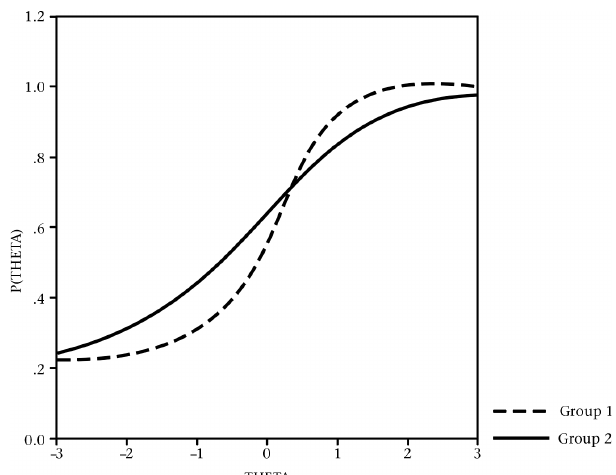
Figure 3: Item showing non-uniform DIF